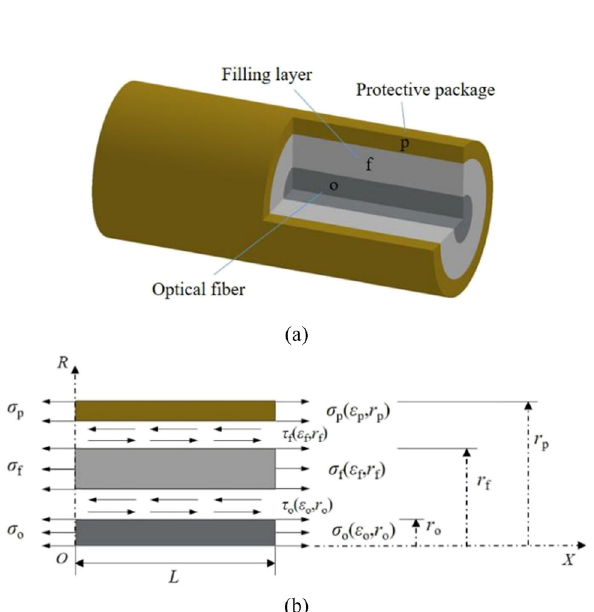
Figure 6: Mechanical analysis of optical fi ber ring tube package: ( a ) packaging structure and ( b ) axisymmetric cross - section and stress